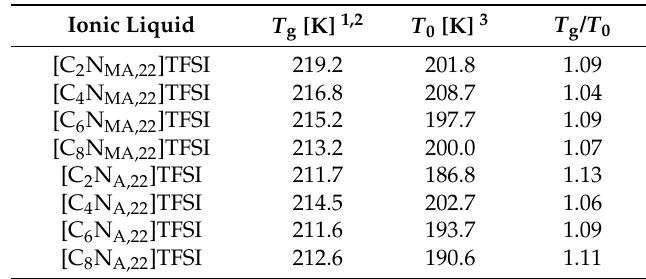
Comparison of experimentally determined T g and calculated T 0 from VFT fit. Standard uncertainties u for values from this work are u ( T g ) = 2